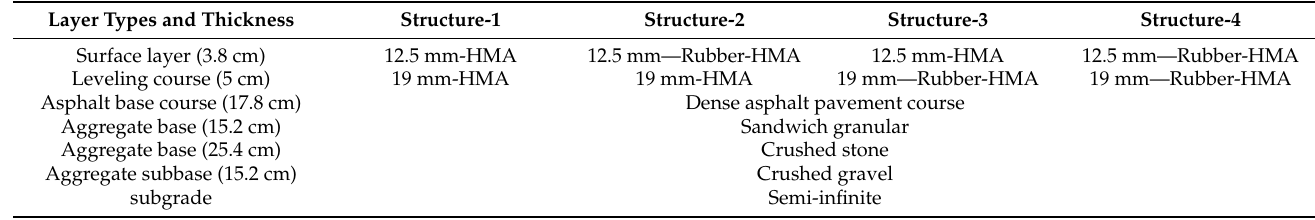
Table 3. Pavement materials and information used in this study.